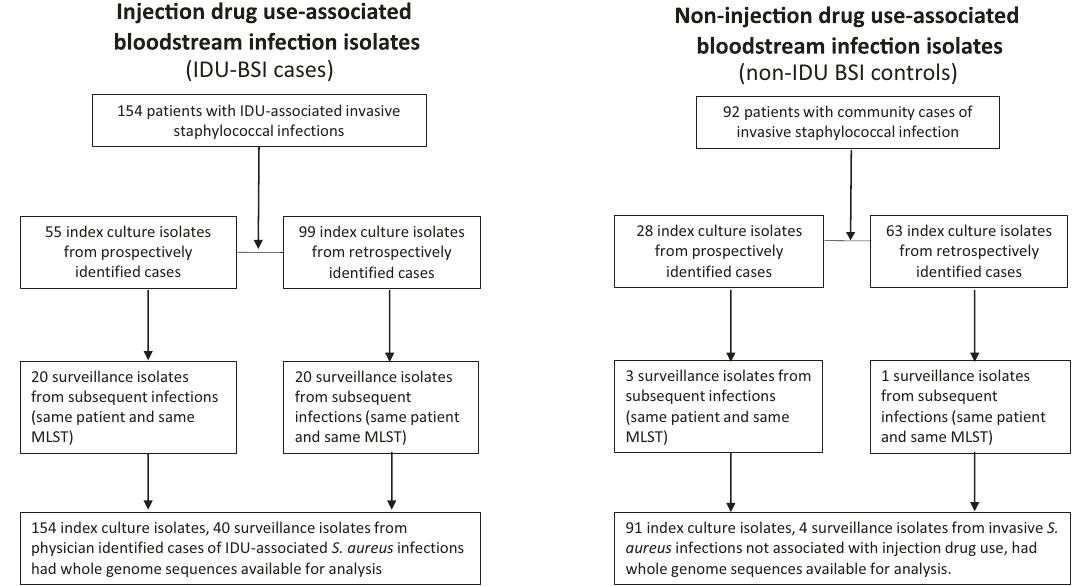
Fig. 1 Isolate Classi fi cation. Flowchart and classi fi cation of study patients based on injection drug use history, study period, and subsequent episode of recurrent S . aureus infection. Abbreviations: BSI, bloodstream infection; IDU, injection drug use; IDU-BSI, injection drug use associated bloodstream infection; MLST, multilocus sequence